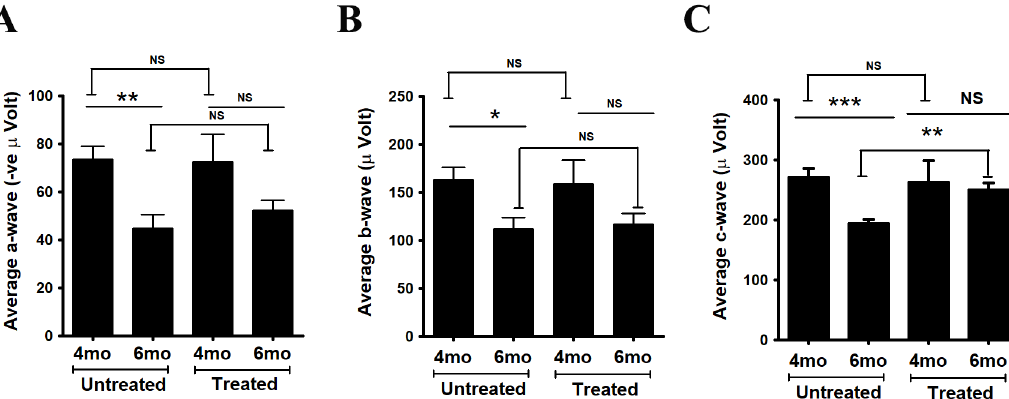
Fig 4. Improvement of RPE function detected by electroretinography. Dark-adapted electroretinogram (ERG) amplitudes measured at a light intensity of 20 cds/m 2 at 4 months (4mo) and 6 months (6mo) of age after initiation of zeaxanthin treatment at 2 months of age. In the untreated group (n = 8), significant changes in (A) a-wave, (B) b-wave and (C) c-wave amplitudes were noticed at 6 months of age compared to 4 months of age. Daily gavage feeding of zeaxanthin did not result in any significant change in (A) a-wave and (B) b-wave amplitudes between control (n = 8) and zeaxanthin treated mice (n = 11) at 6 months (6mo) of age (4 months after onset of treatment). However, zeaxanthin fed Sod2 flox/flox VMD2-cre (C) mice had greater c-wave amplitudes at 6 months (6mo) of age (4 months after onset of treatment) than did the untreated Sod2 flox/flox VMD2-cre mice at 6 months (6mo) of age following flashes of same light intensity ( (cid:3)(cid:3) P <